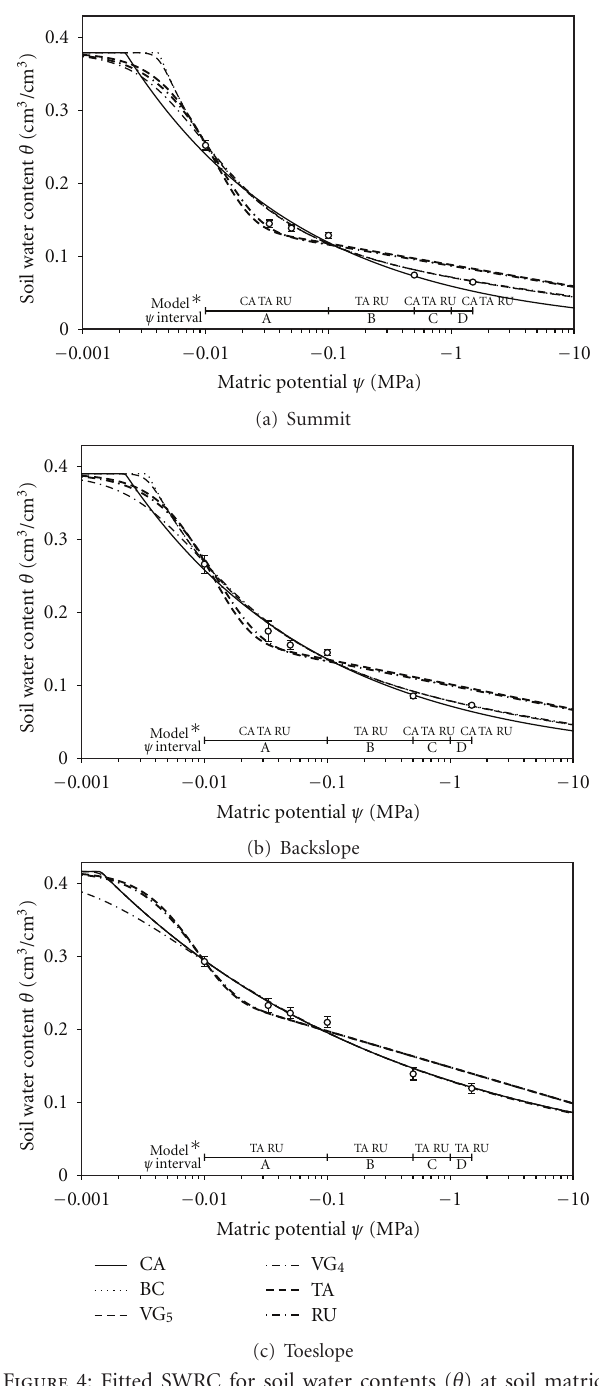
Figure 4: Fitted SWRC for soil water contents ( θ ) at soil matric potentials ( ψ ) for the (a) summit, (b) backslope, and (c) toeslope positions using the Campbell (CA) model with absent θ r parameter, and Brooks-Corey (BC), five- and four-parameter van Genuchten (VG 5 and VG 4 ), Tani (TA), and Russo (RU) models with θ r modified as one of the fitted parameters. Hillslopes are averaged. Error bars are SE for six water retention measurements. Model ∗ represents SWRC models that have significantly di ff erent water re- tention within a water potential interval compared to the BC model. Water potential ( ψ ) intervals A: − 0.01 to − 0.1 MPa; B: − 0.1 to − 0.5MPa; C: − 0.5 to − 1.0MPa; D: − 1.0 to − 1.5MPa represent groups of minimum threshold water potential sensitivity for